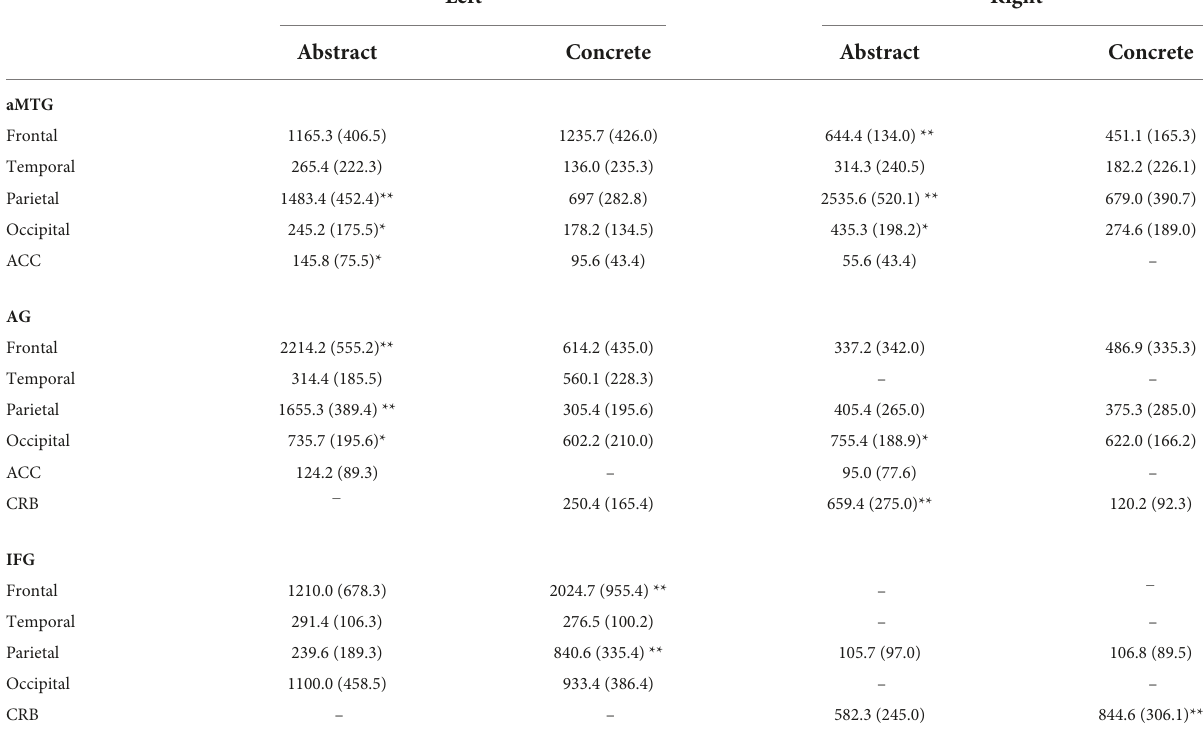
TABLE 4 Cluster sizes of connected areas by semantic